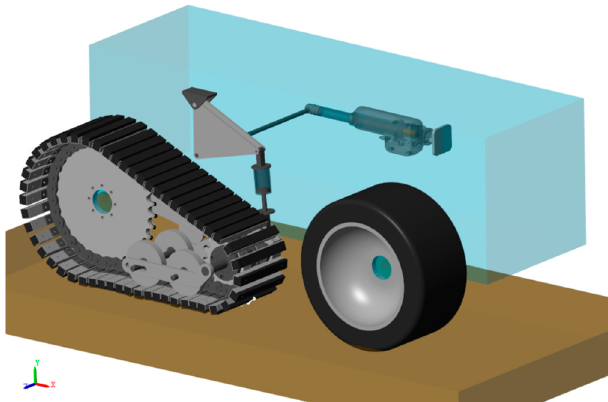
Figure 1. 3D view of the multibody model of the farming robot.